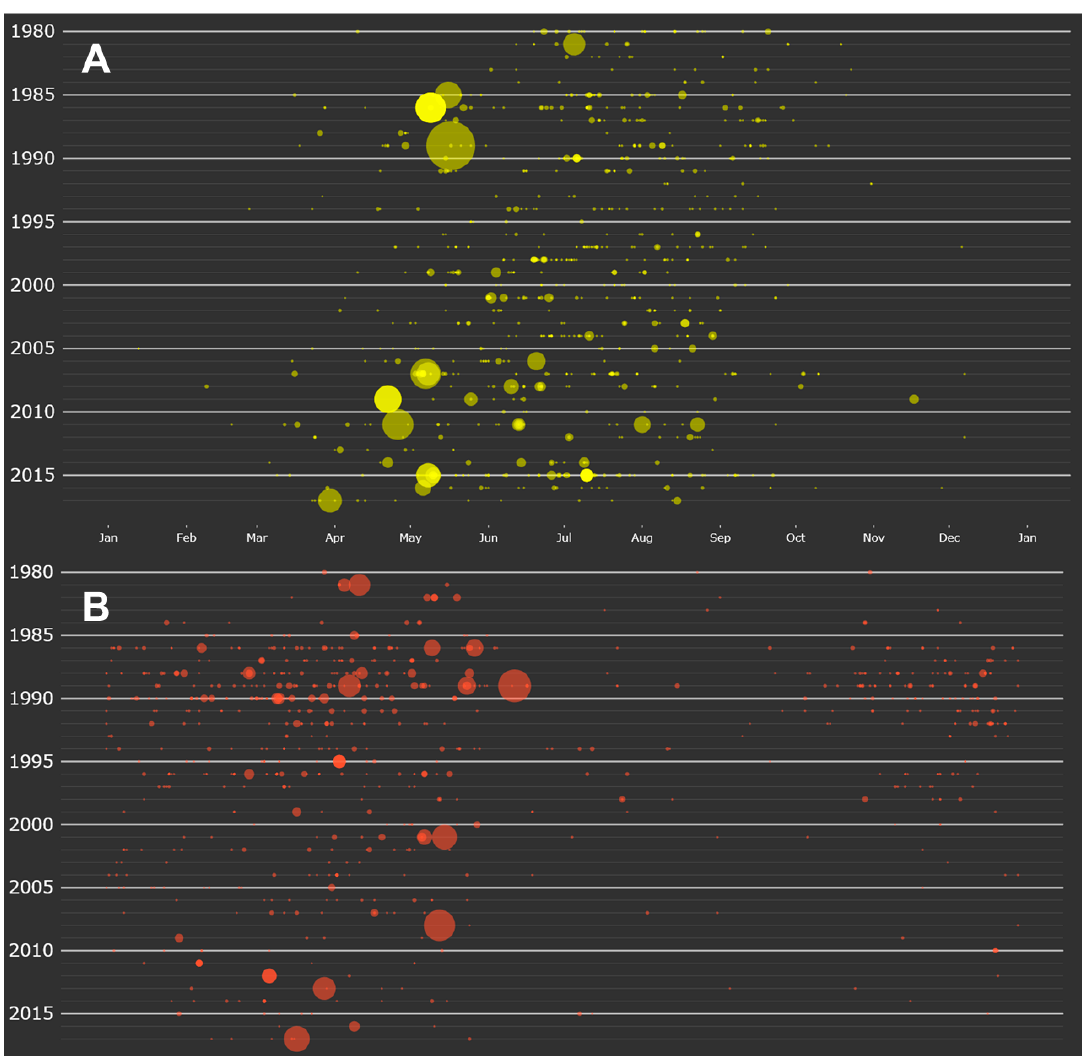
Figure 5. Natural wildfires ( A ) and human-caused wildfire occurrences ( B ) in Big Cypress National Preserve and Everglades National Park between 1980 and 2017. The size of each point corresponds to the size of the fire.